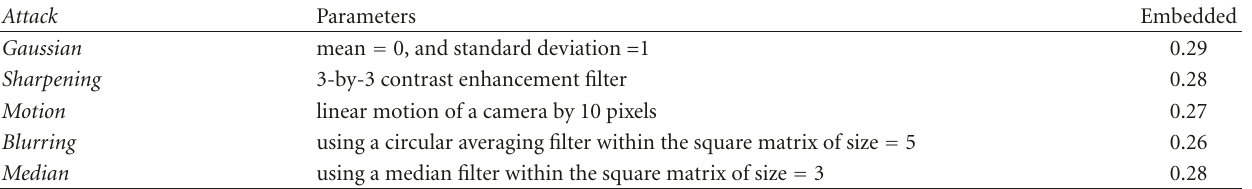
Table 2: Mutual information values between the original watermark and the extracted one after attacks. Attack Parameters Embedded Gaussian mean = 0, and standard deviation = 1 0.29 Sharpening 3-by-3 contrast enhancement filter 0.28 Motion linear motion of a camera by 10 pixels 0.27 Blurring using a circular averaging filter within the square matrix of size = 5 0.26 Median using a median filter within the square matrix of size = 3